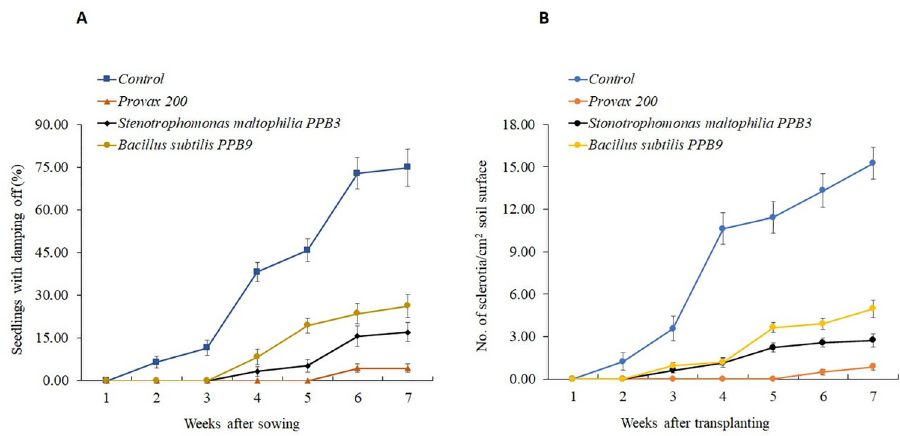
Fig 3. Development of damping-off and sclerotia caused by Sclerotium rolfsii in protected and unprotected seedlings of tomato in seed trays. Bacteria-protected tomato seedlings against the pathogen were obtained by treating seeds with S tenotrophomonas maltophilia PPB3 and Bacillus subtilis PPB9. Seedlings from Provax 200 (0.3% w/v)- treated seeds were considered fungicide-protected checks, while those from sterilized-treated water seeds were deemed to be unprotected controls (Control). After autoclaving, field soil mixed with S . rolfsii inocula was placed in seed trays (20 × 10 × 5cm). Each tray was sown with 30 tomato seeds and grown in a growth room at 24˚C temperature and a 16/8 h photoperiod for seven weeks. Seedlings with damping-off symptoms were counted weekly (A). The number of sclerotia formed on soil surfaces was counted and expressed per cm 2 surface area (B). In each graph, each point in the line represents the mean value within each treatment category. Vertical lines denote the standard